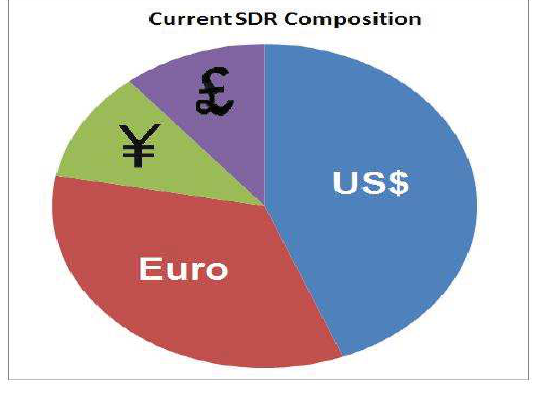
Fig. 1. Special drawing rights